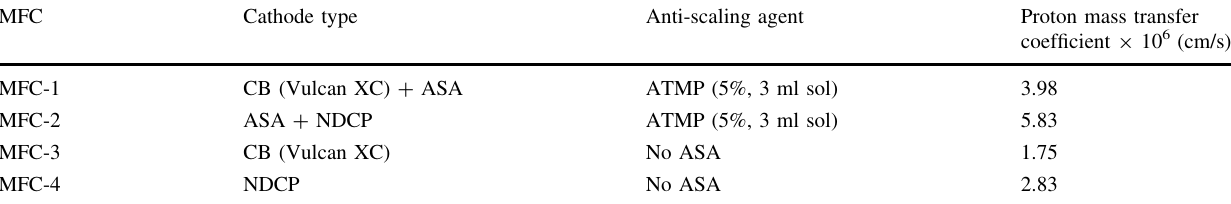
Table 1 Cathode description of MFCs used in the study MFC Cathode